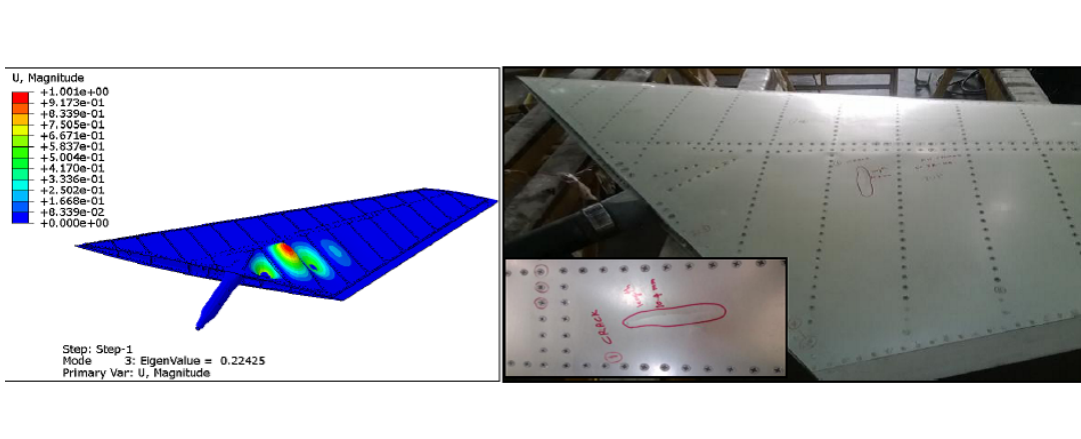
Figure 4: (a) Buckling Plot of Metallic Structure (b) Failure on Actual Structure